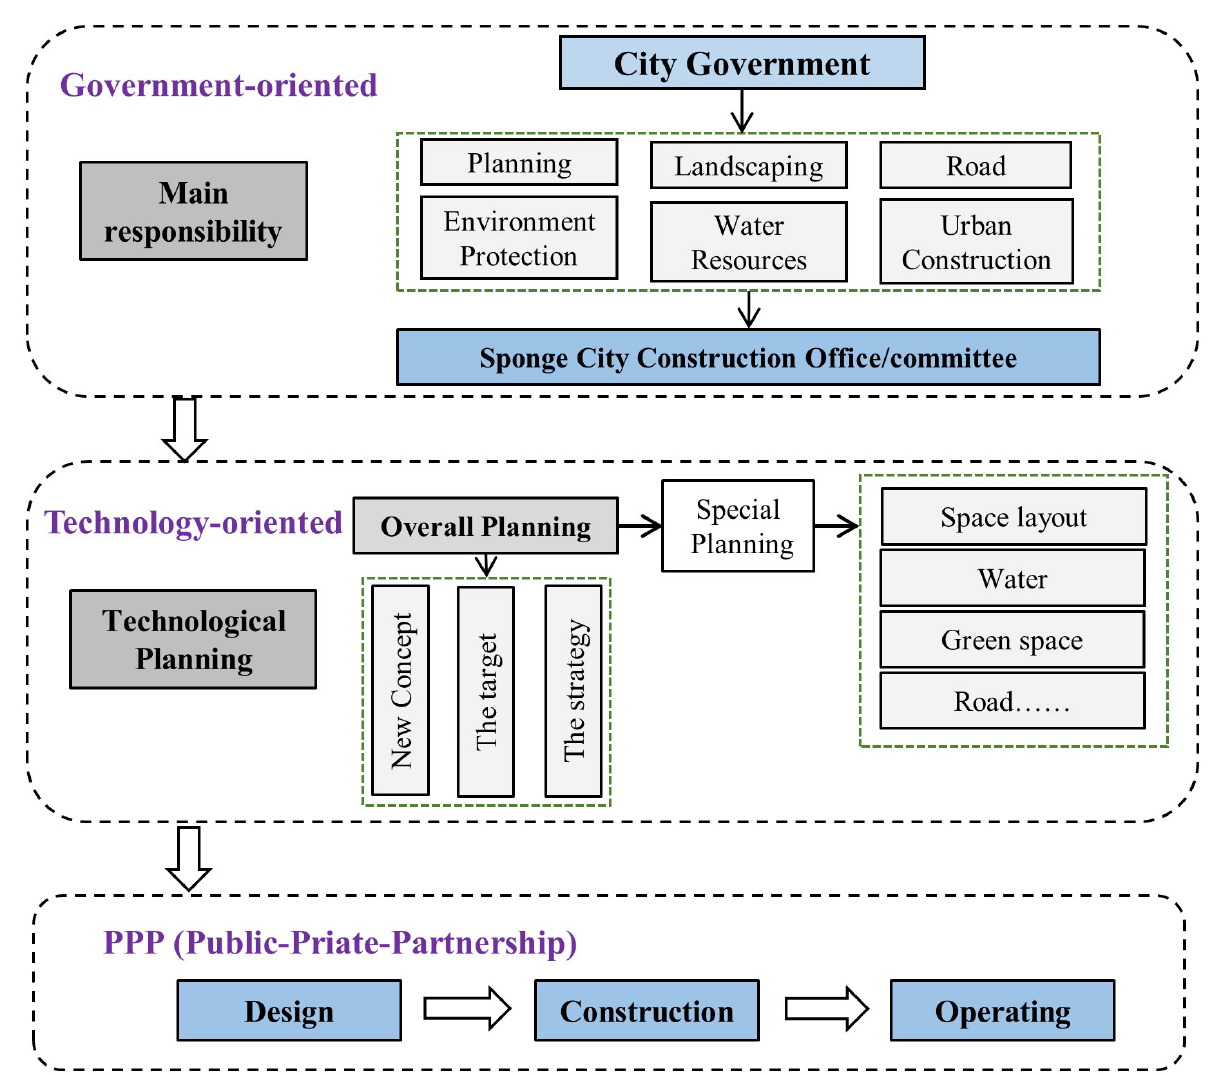
Figure 3. Chinese implementation mode of sponge city pilot